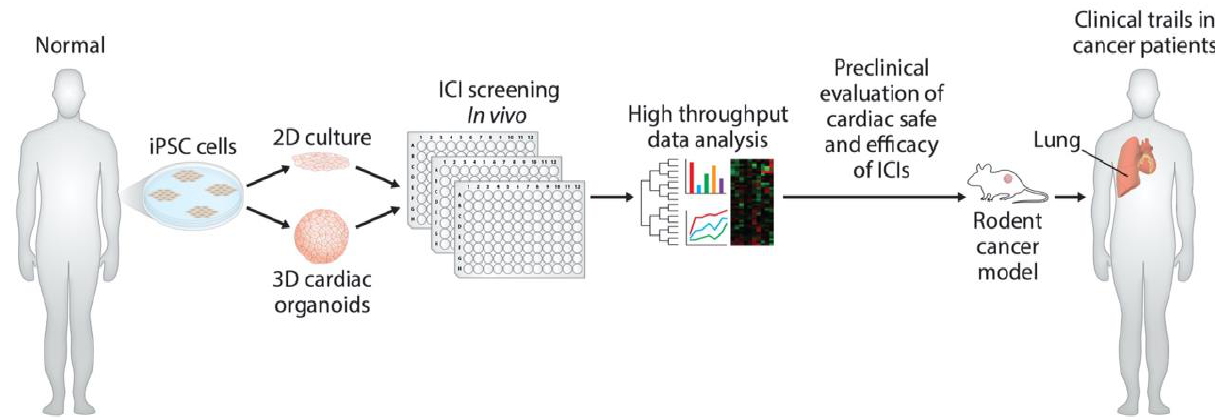
Figure 3. Development of preclinical models and determination of cardiac-safe ICIs. Diagram illustrates the use of hiPSC to develop in vitro human cardiomyocytes and cardiac organoids. These in vitro models can be used to screen monoclonal antibody-based ICIs for their cardiac toxicity. Further in vitro cardiac-safe ICIs can now be tested for toxicity in mouse tumor models and in cancer